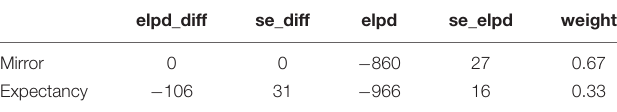
TABLE 8 | Comparison of Mirror and Expectancy